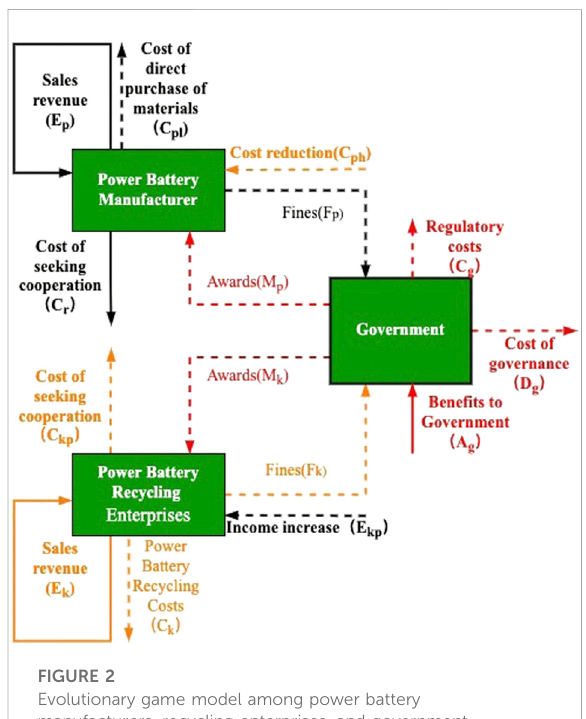
FIGURE 2 Evolutionary game model among power battery manufacturers, recycling enterprises, and